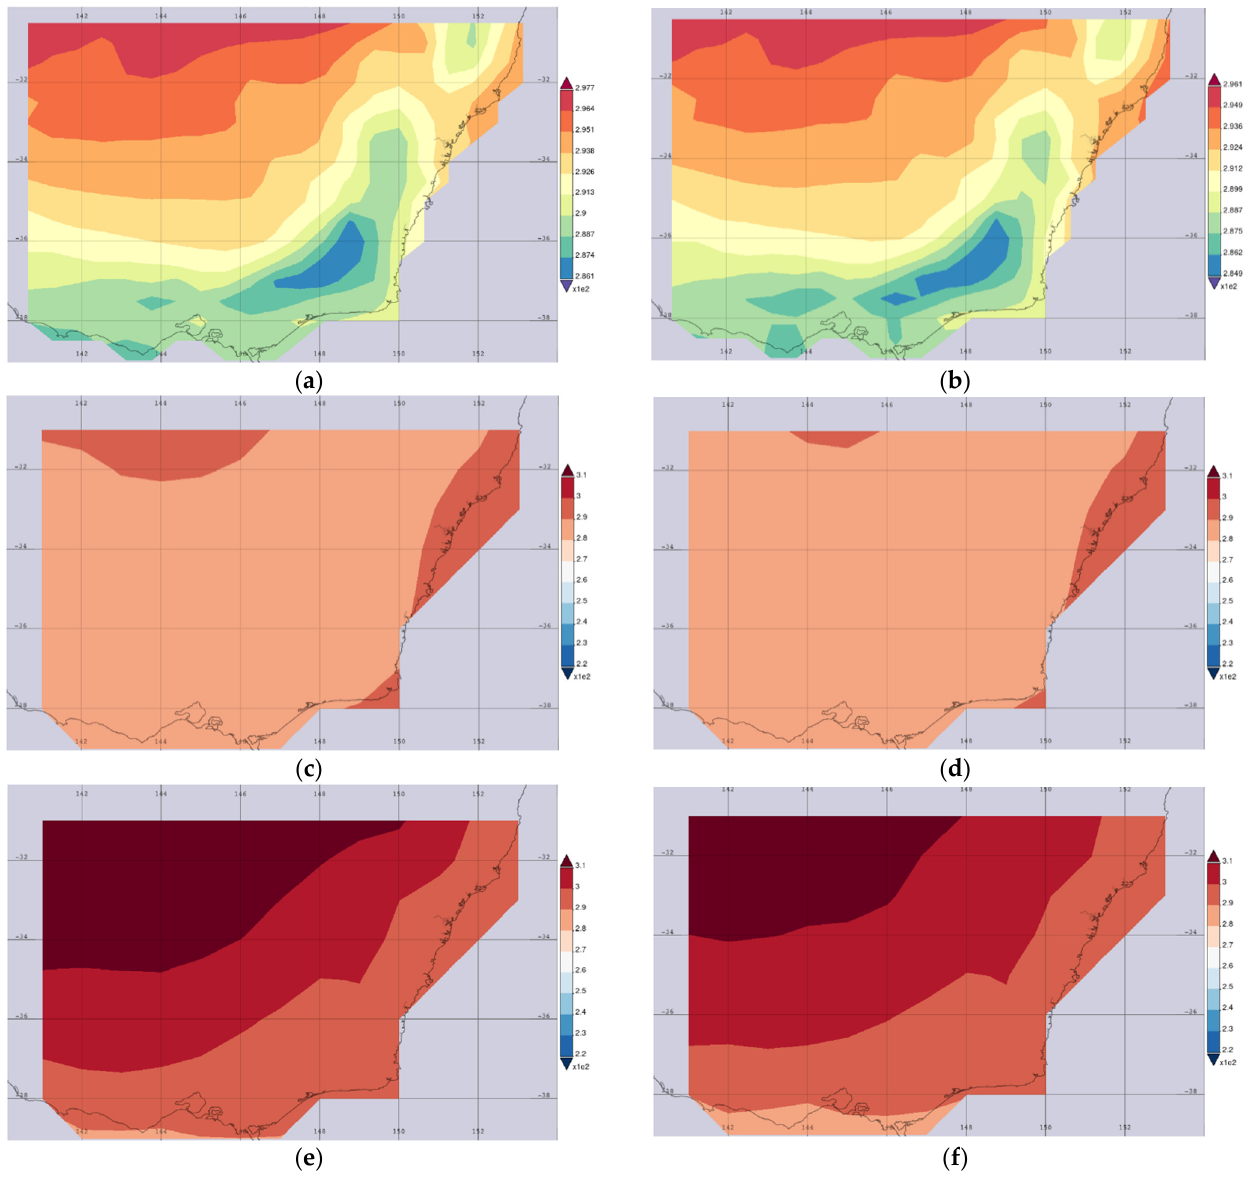
Figure 3. Time average map of surface temperature at NSW for day and night time for a period of